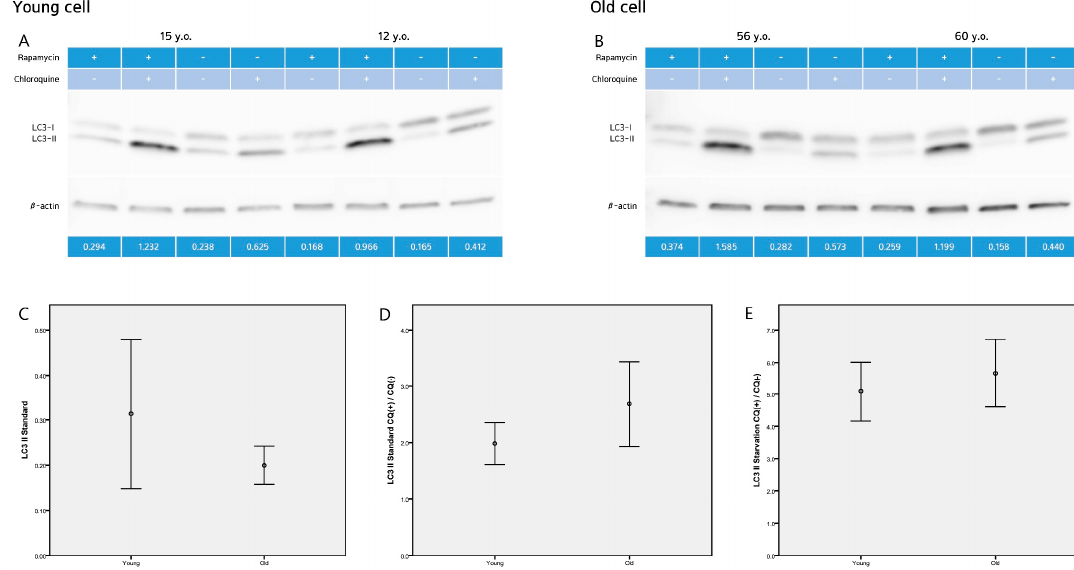
Figure 4. Western blot analysis ( A , B ) revealed that the level of LC3-II protein, were ( C ) 0.31 ± 0.23 (young fibroblasts) and 0.20 ± 0.76 (old fibroblasts) ( p = 0.087) at standard (basal) conditions. ( D ) The ratio of LC3-II with and without chloroquine were 1.98 ± 0.52 (young fibroblasts) and 2.68 ± 1.37 (old fibroblasts) ( p = 0.138) at standard conditions. ( E ) Under starvation conditions (induced by rapamycin), the ratio of LC3-II with and without chloroquine increased to 5.09 ± 0.52 (young fibroblasts) and 5.66 ± 1.90 (old fibroblasts) ( p = 0.413). Images are representative of two separate experiments on n = 32 samples (15 young and 17 old). LC3-II expression is normalized to actin (arbitrary units). Data are provided as mean ± SD. p values < 0.05 were considered statistically significant.